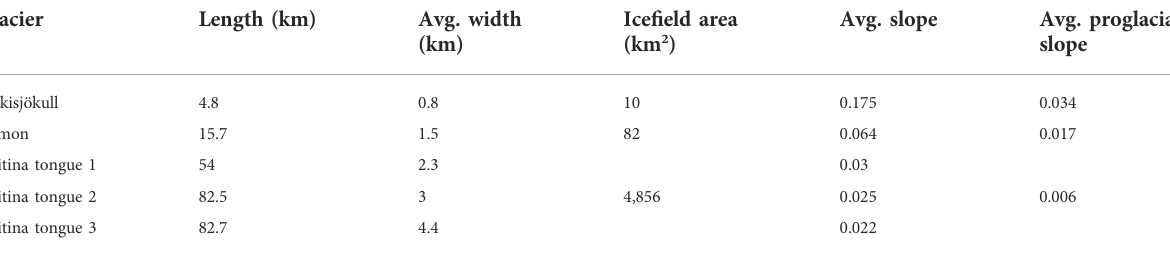
TABLE 2 Dimensions of glaciers and slopes of proglacial systems studied in Sweet and Brannan (2016), Pippin (2016), and Kalinska et al. (2021).